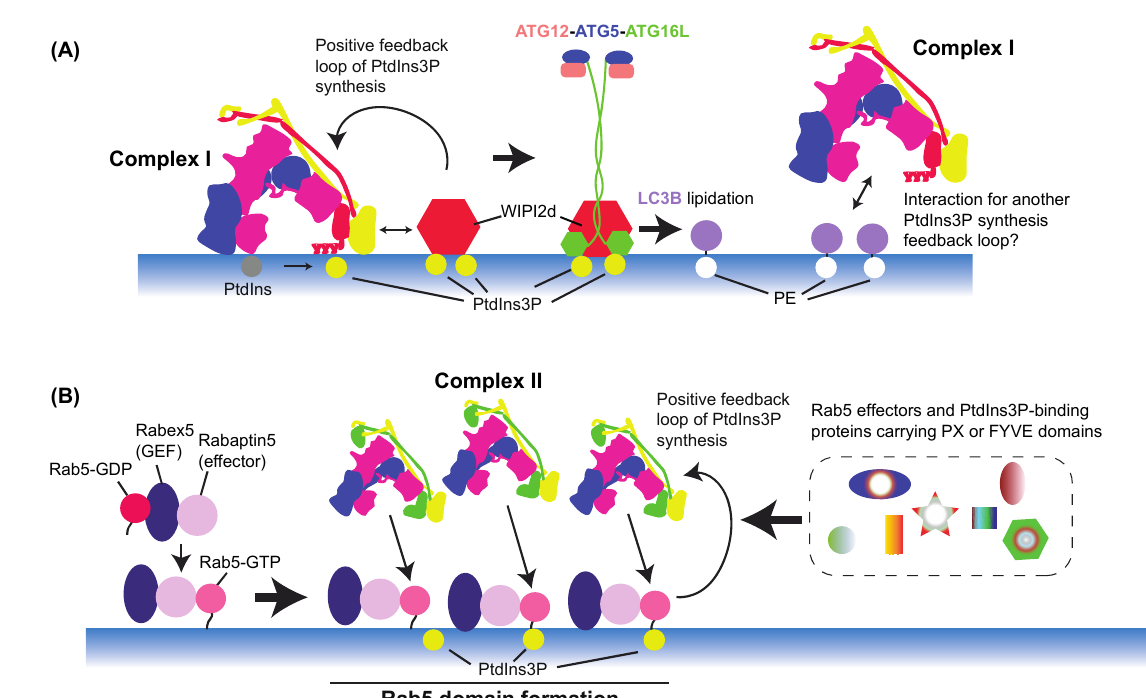
Figure 7. Positive PtdIns(3)P feedback mechanisms via complexes I (A) and II (B). ( A ) Complex I is activated by its effector WIPI2d, which leads to a positive feedback loop of PtdIns(3)P synthesis. WIPI2d also facilitates the LC3B lipidation by interacting with the ATG12–ATG5–ATG16L E3 complex. GABARAP and GABARAPL1, Atg8 family proteins, are known to preferably interact with complex I, but the consequence of this interaction remains to be seen. ( B ) On early endosomes, Rab5 interacts with its GEF-effector complex, the Rabex5–Rabaptin5 complex. This interaction switches the Rab5 nucleotide binding from GDP to GTP and its binding partner from Rabex5 to Rabaptin5. This interaction causes the formation of Rab5 domain (clustering), which is enhanced by PtdIns(3)P, indicating positive feedback between Rab5–Rabex5–Rabaptin5 and complex II. These Rab5- and PtdIns(3)P-enriched clusters recruit more Rab5 effectors and PtdIns(3)P-binding proteins carrying PX and FYVE domains.